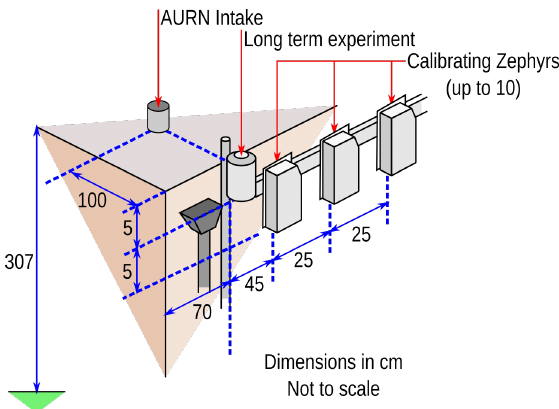
Figure 8. Isometric diagram of the relative positioning of Zephyr sensors near the roof of the AURN station. The lip of the roof is roughly 3 m from the